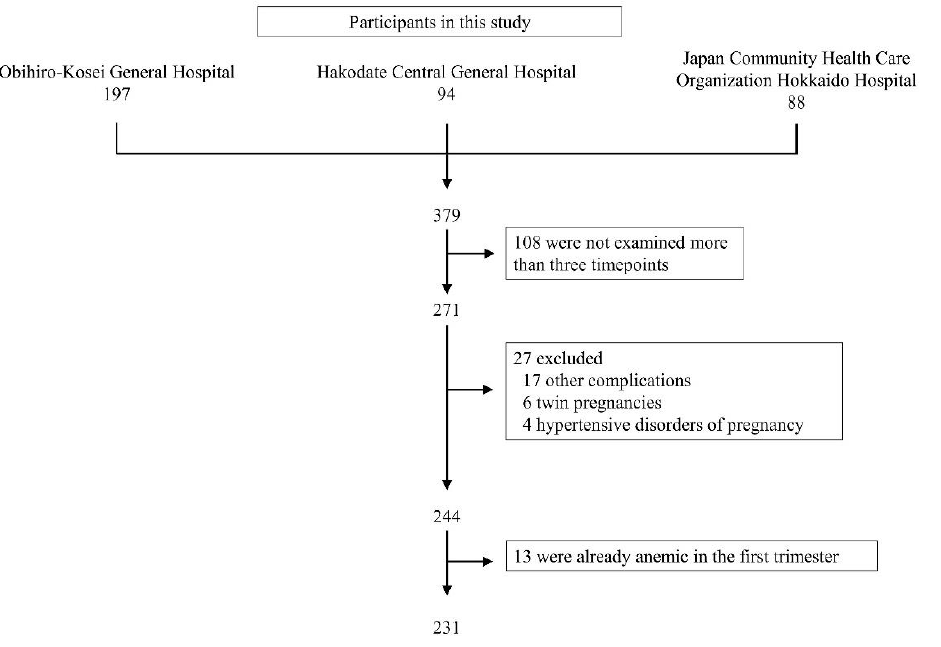
Figure 1. Study design.